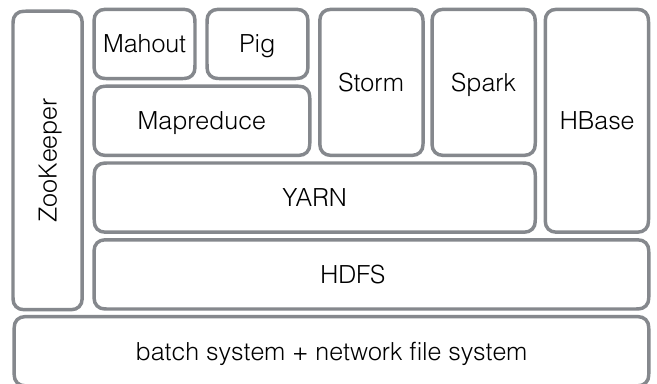
Figure 1. Magpie can support a large part of the Hadoop ecosystem on top of a traditional batch and file